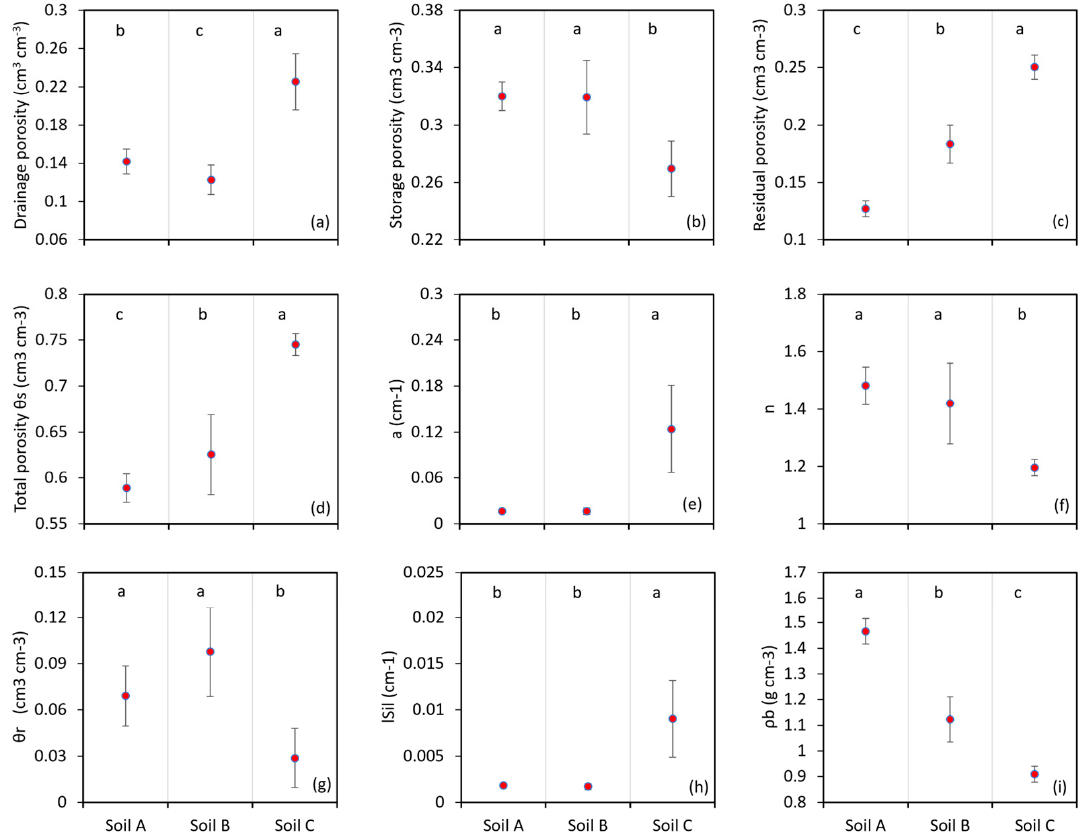
Figure 4. Mean ± S.E. of drainage ( a ), storage ( b ), residual ( c ), and total (measured θ s ) porosities ( d ), fitted van Genuchten parameters ( e – h ), and ρ b ( i ) together with the statistical LSD comparison between soils based on all treatments for each parameter. Different scales of the y axis were used to clarify the graphs. The same letter indicates no statistical differences among treatments.